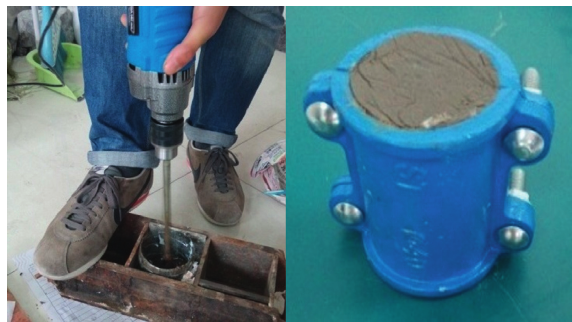
Figure 3: Making of resin anchor agent.